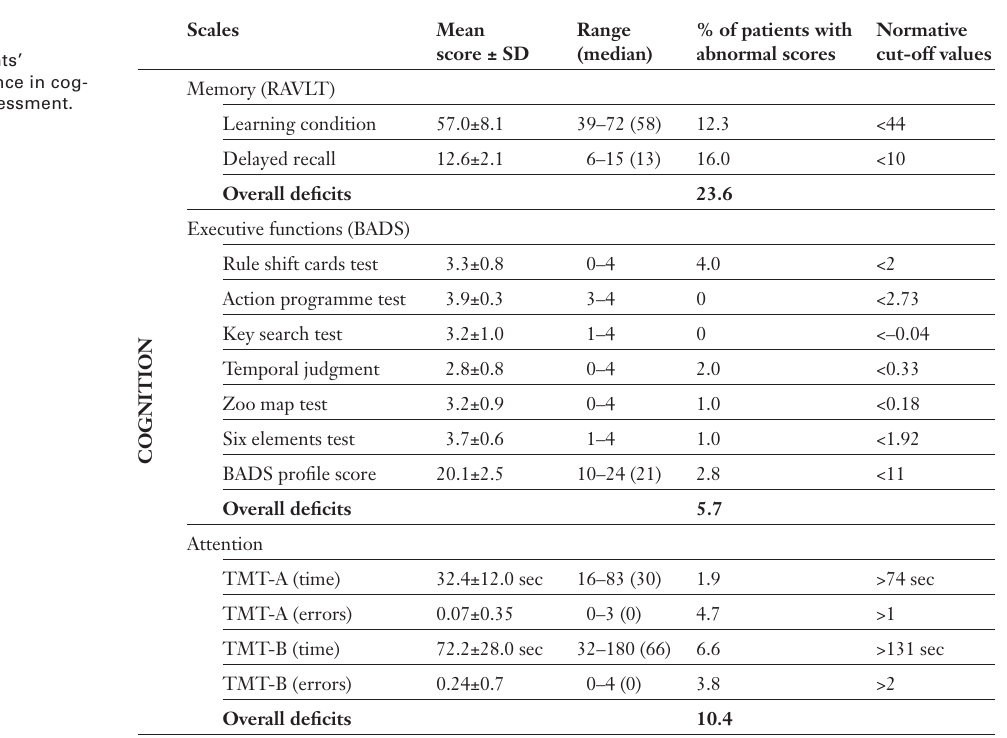
Table 3 MS patients’ performance in cog- nitive assessment.